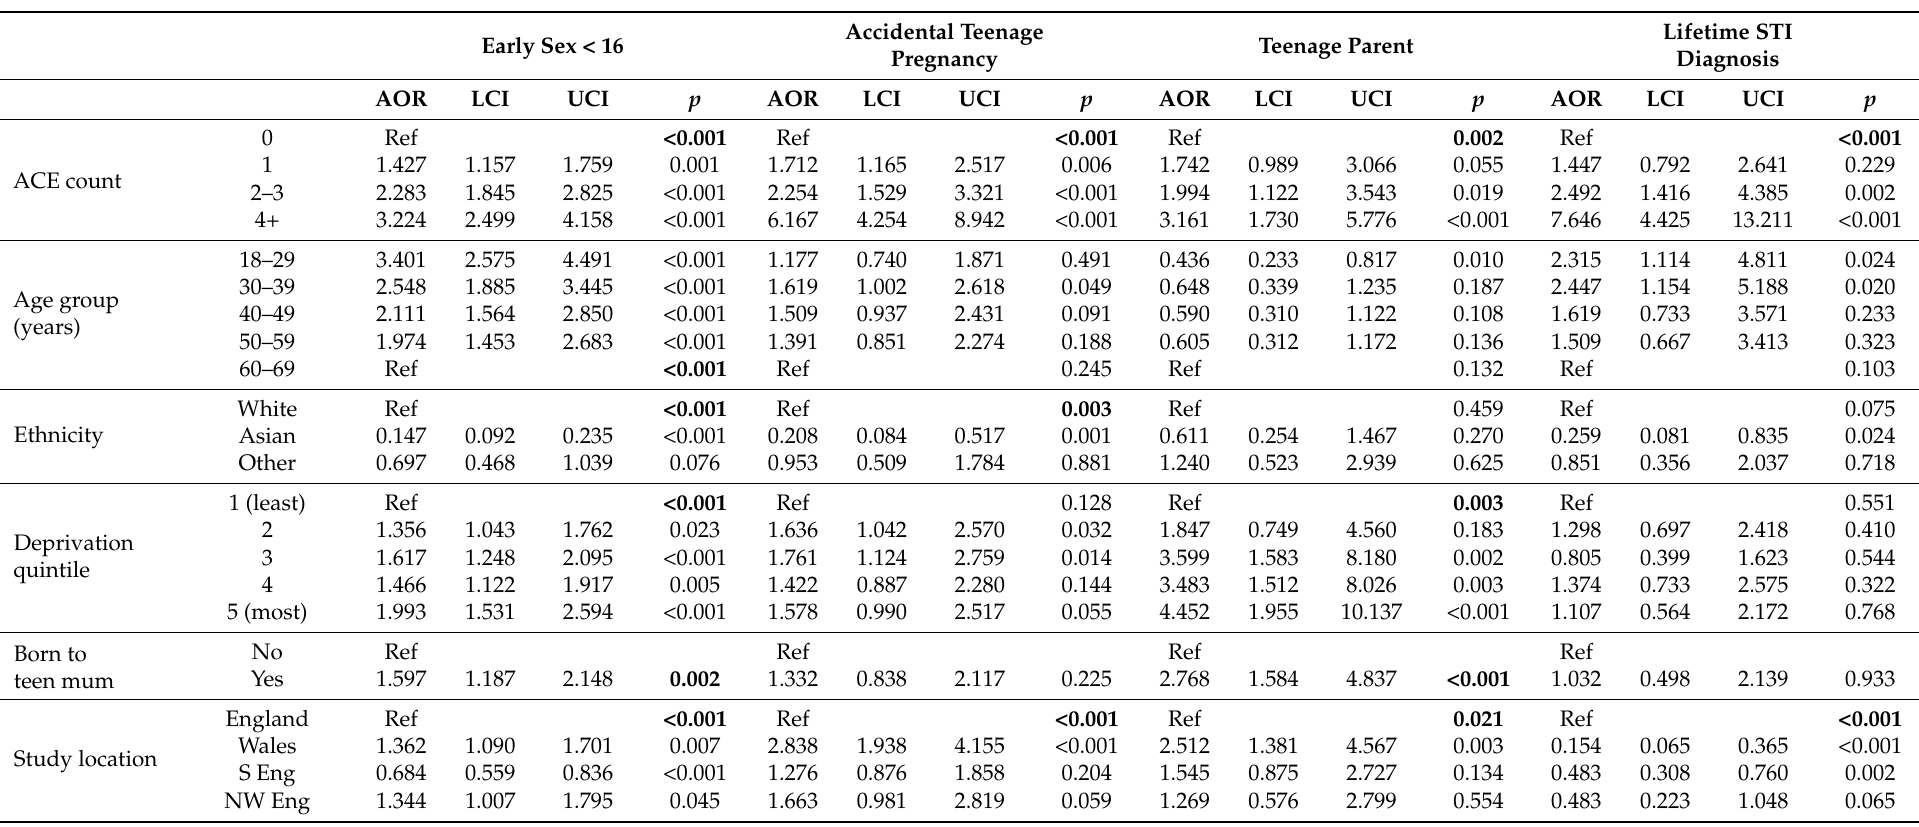
Table 2. Adjusted odds ratios for sexual health outcomes: